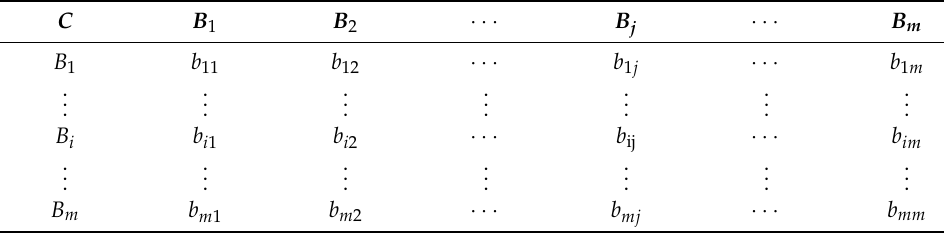
Table 4. Unified aggregation judgment matrix